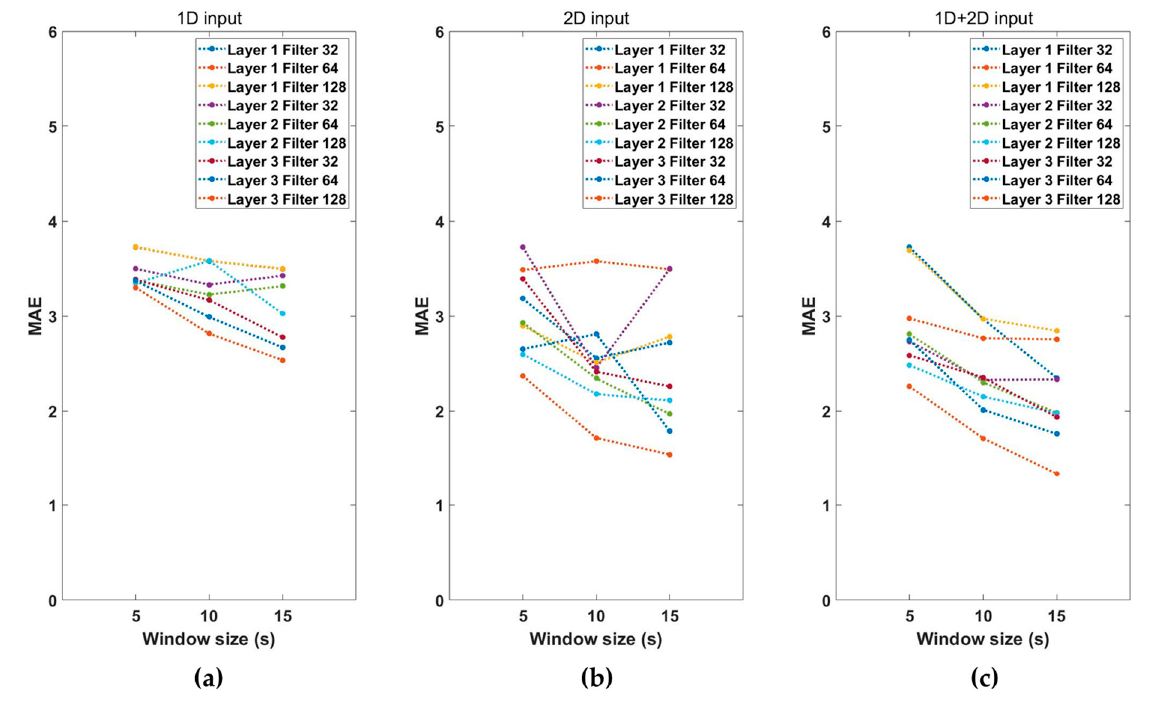
Figure 4. Performance of the ( a ) 1D input model, ( b ) 2D input model, and ( c ) 1D + 2D input model with the number of layers, filter size, and segment window size. Table 2. Configuration summary of the proposed model.